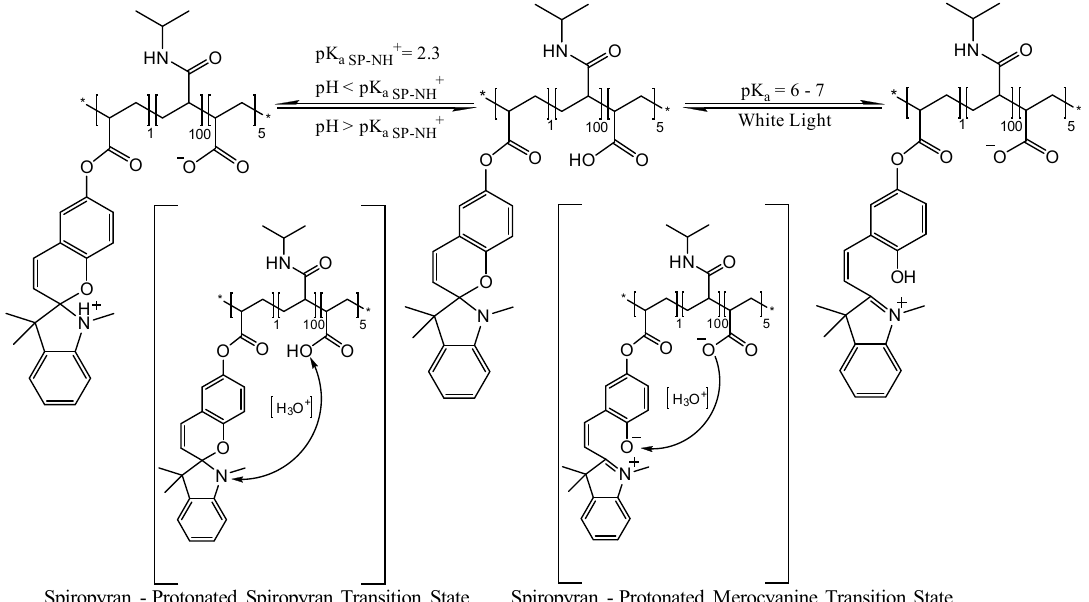
Scheme 2. Scheme showing the equilibrium of p(NiPAAm ‐ BSP ‐ AA) copolymer in DI water under different illumination conditions.